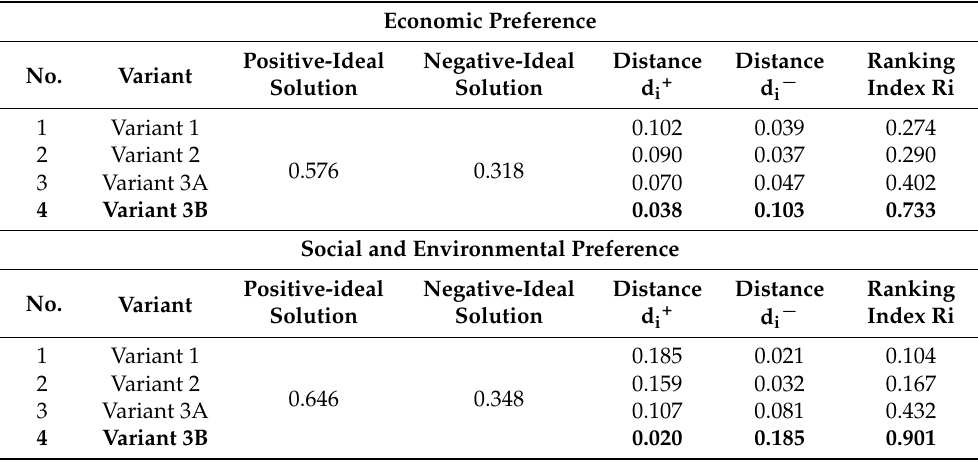
Table 11. Ideal and anti-ideal solutions, distances and ranking factors.